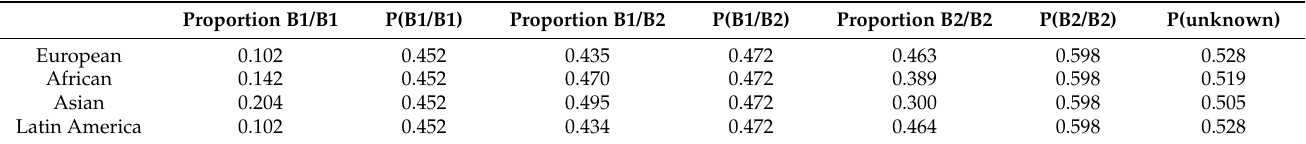
Table 4. Response to omega-3 supplementation in each ethnicity.